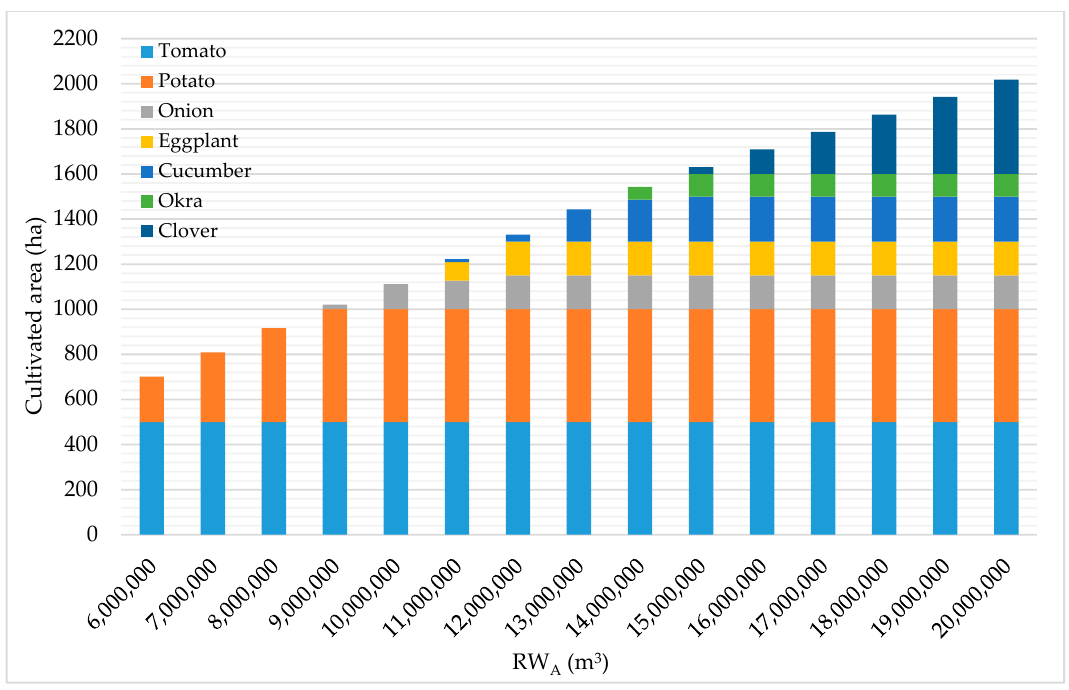
Figure 10. Predicted area (ha) of crops irrigated using reclaimed water type A (RW A ) with 85% IE.